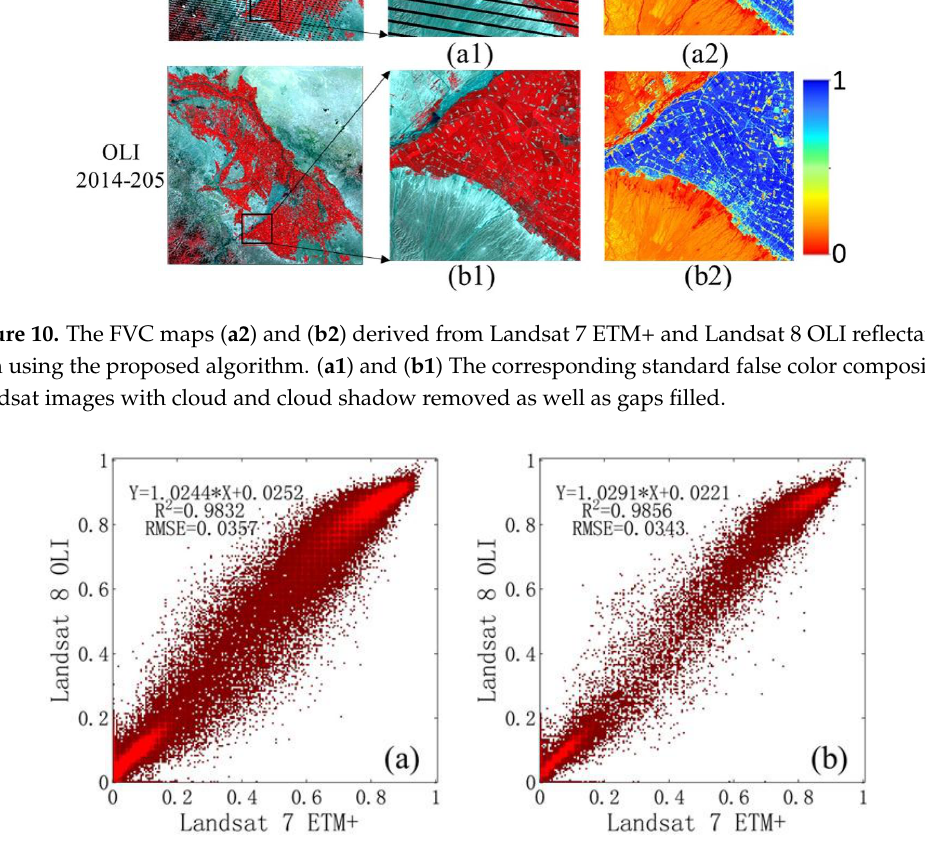
Figure 11. Comparison of relationship between FVC values estimated from Landsat 7 ETM+ and FVC values estimated from Landsat 8 OLI. The density map presents the densities of the points. The FVC values estimated from Landsat 7 ETM+: ( a ) from actual scanned pixels; and ( b ) estimated from predicted values of un-scanned pixels.